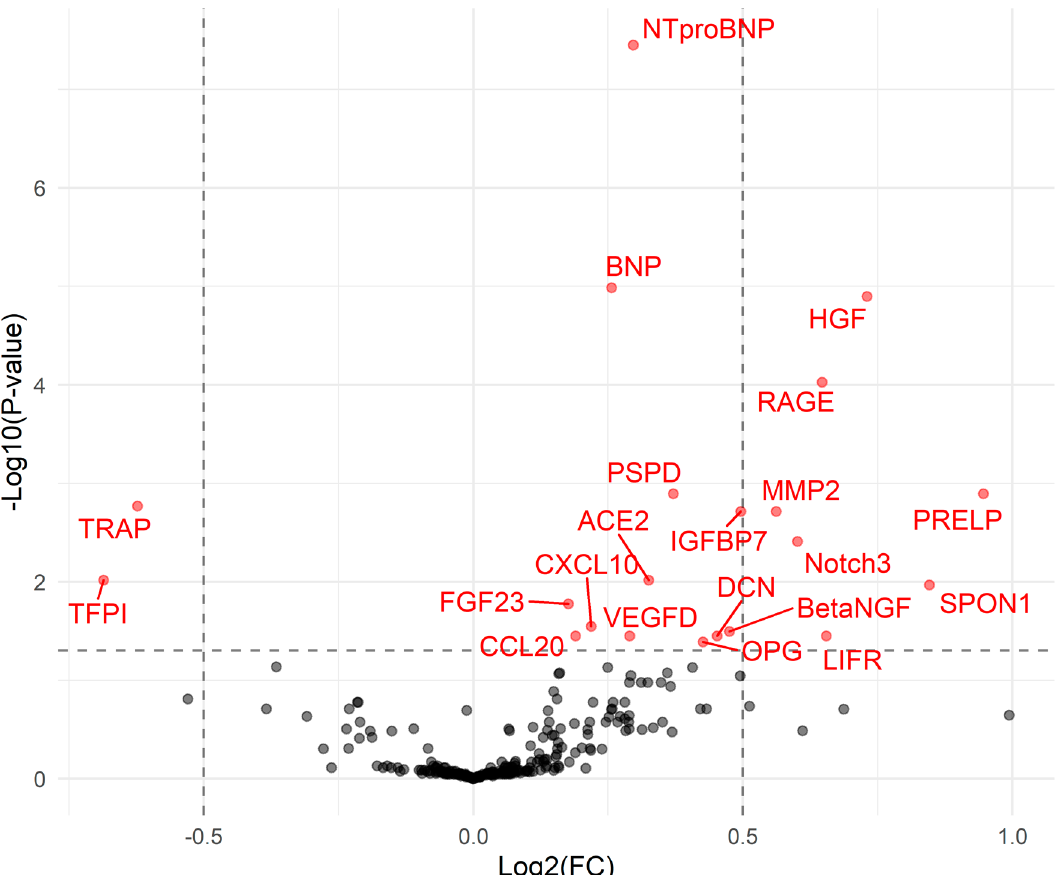
Figure 4. Association of plasma proteins with disproportionate LA myopathy in PROMIS-HFpEF. The volcano plot shows proteins positively and negatively associated with disproportionate LA myopathy. The y-axis represents false-discovery rate adjusted P-values. There were 21 proteins associated with disproportionate LA myopathy (red) after adjustment for multiple